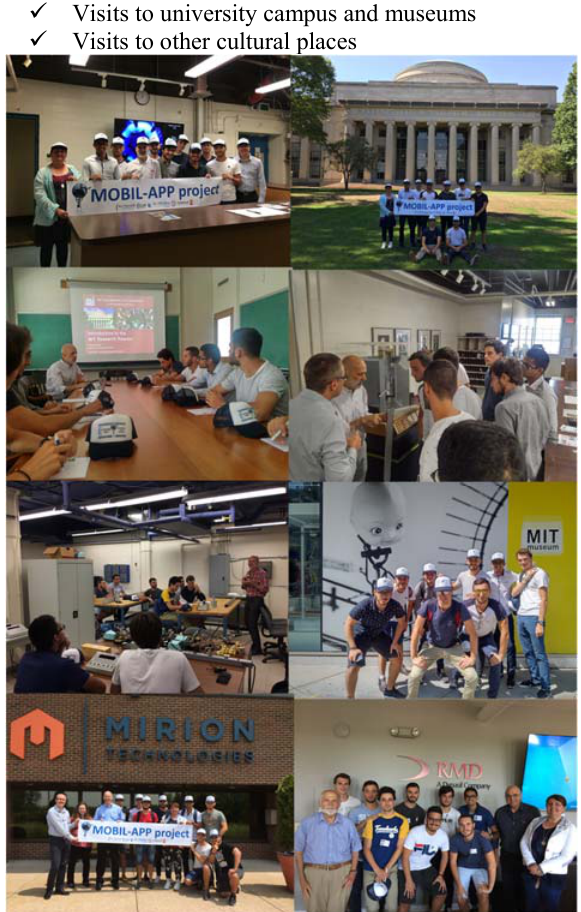
Fig. 6. Photographs associated to the mobility period in